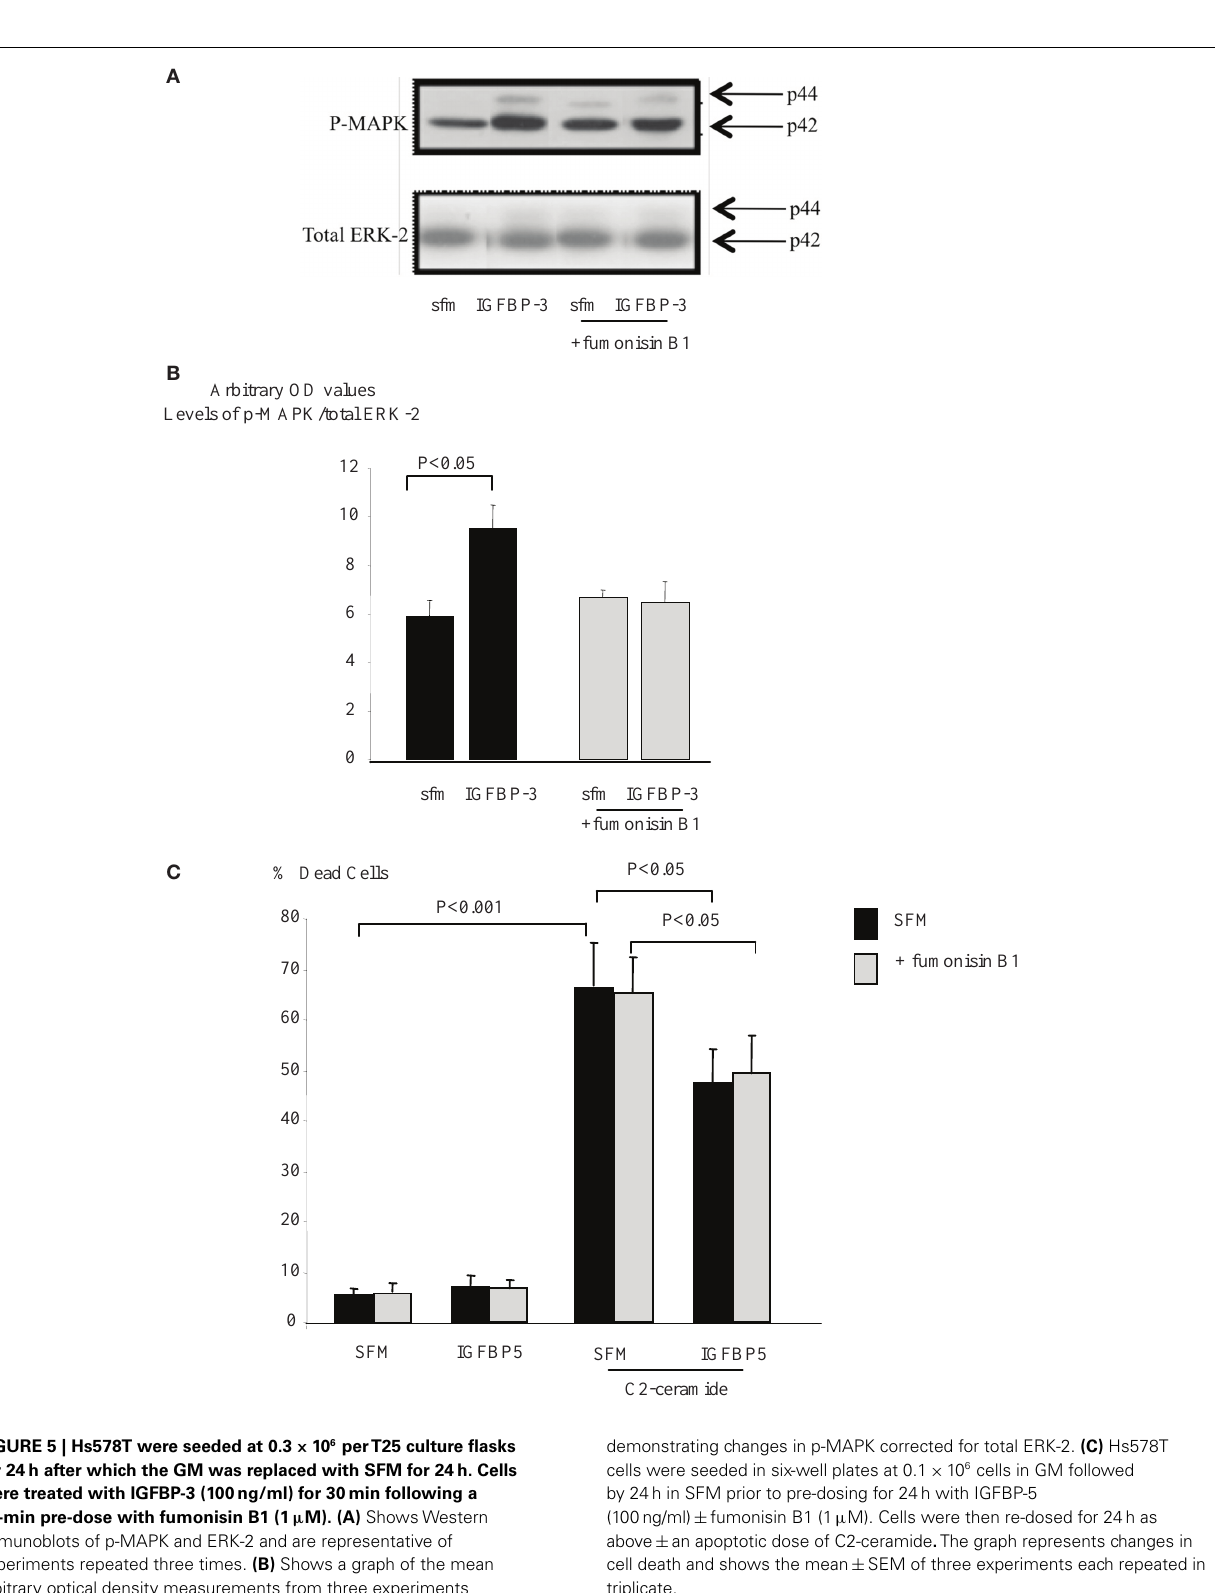
demonstrating changes in p-MAPK corrected for total ERK-2. (C) Hs578T cells were seeded in six-well plates at 0.1 × 10 6 cells in GM followed by 24h in SFM prior to pre-dosing for 24h with IGFBP-5 (100ng/ml) ± fumonisin B1 (1 μ M). Cells were then re-dosed for 24h as above ± an apoptotic dose of C2-ceramide . The graph represents changes in cell death and shows the mean ± SEM of three experiments each repeated in